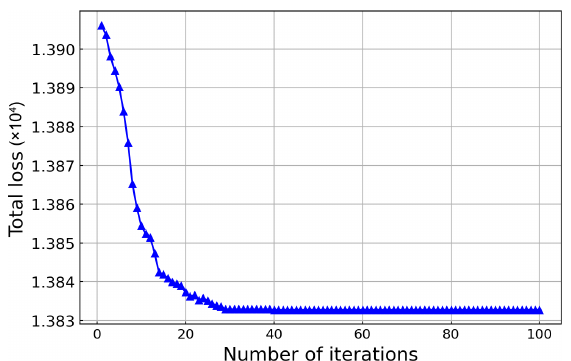
Fig. 6 Total loss with different numbers of iterations.